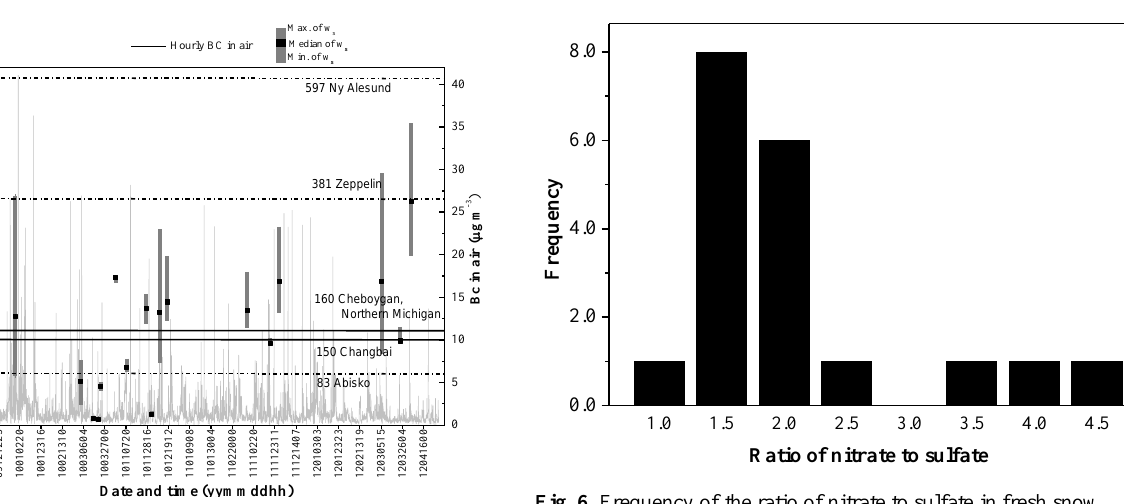
Fig. 5. Hourly mean concentrations of BC (μg m −3 ) in air and EC scavenging ratio from 2009 to 2012. (Data from Zeppelin and Ny-Alesund are from Hegg et al., 2011; Abisko from Noone and Clarke, 1988; and Cheboygan from Cadle and Dasch, 1988).